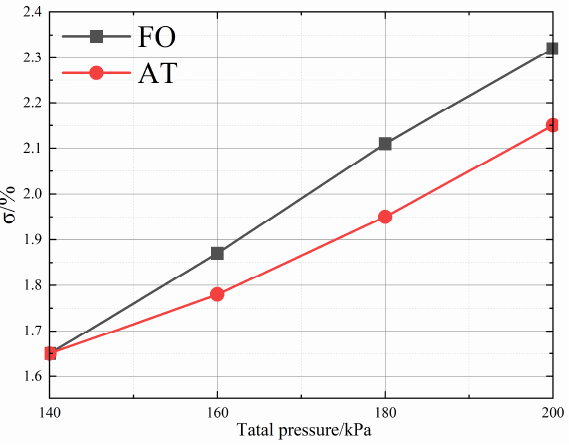
Figure 15. The total pressure loss coefficient at various inlet total pressures.